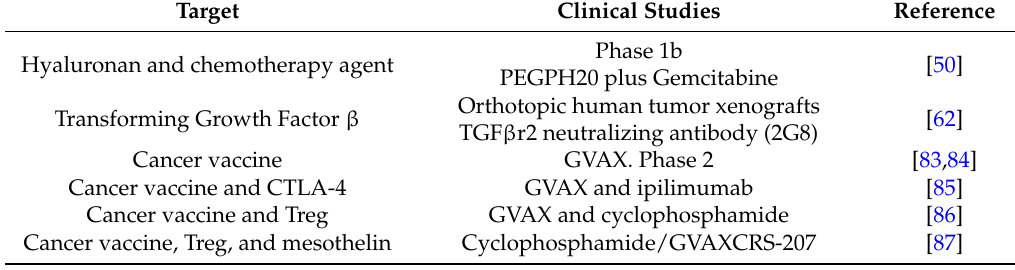
Table 1. Summary of selected agents targeting microenvironmental factors in pancreatic cancer.